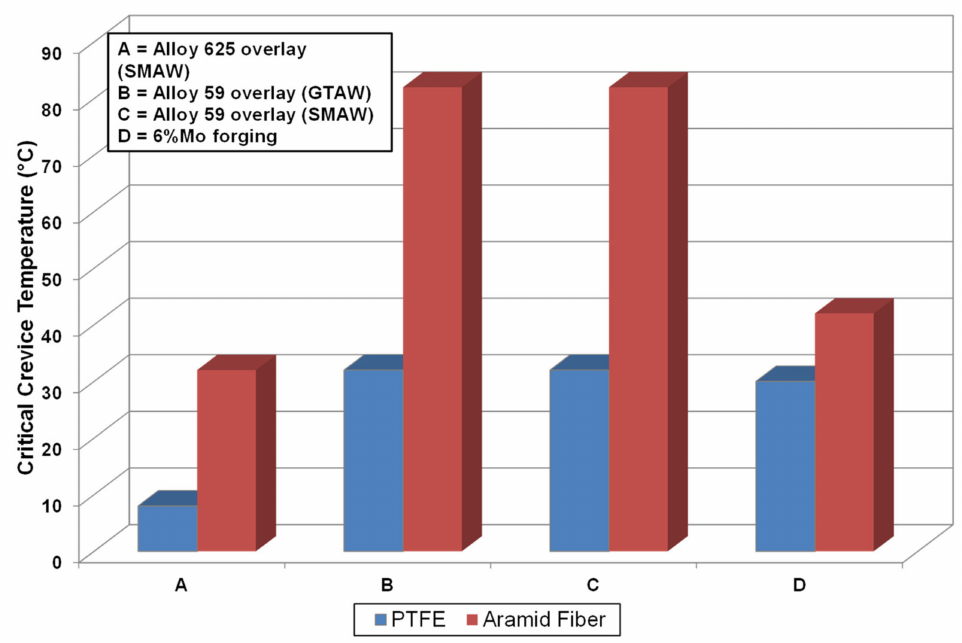
Figure 3. Critical crevice temperature for 6%Mo austenitic stainless steel with different gaskets at +600 mV SCE. Adapted from